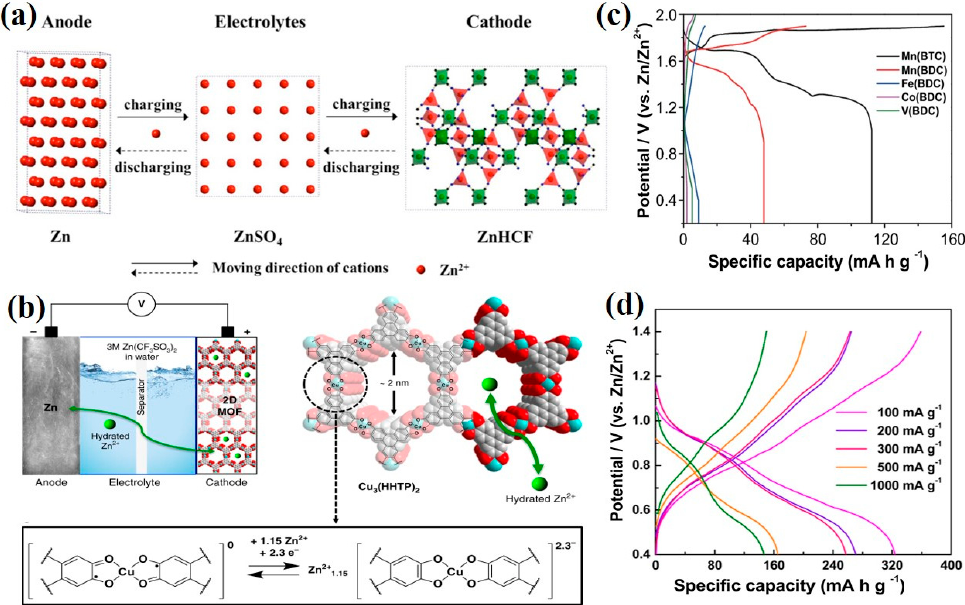
Figure 2. S chemes follow the same forma tt ing. ( a ) A schematic of the Zn//ZnHCF ba tt ery. ( b ) Struc- ture and expected redox process in the coordination unit of Cu 3 (HHTP) 2 . ( c ) Charge/discharge Copyright 2014, John Wiley and Sons. ( b ) Structure and expected redox process in the coordination curves at 50 mA g − 1 of Mn(BTC), Mn(BDC), Fe(BDC), Co(BDC), and V(BDC) cathodes. ( d ) Galvanos- tatic charge/discharge pro fi le of V-MOF (MIL-47) at di ff erent current densities.